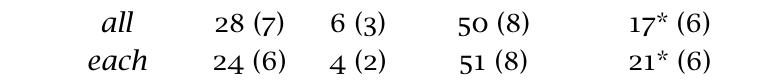
Percentages of choices of each option (standard errors in parentheses), Experiment 2 . “Strengthened" alternative indicated by